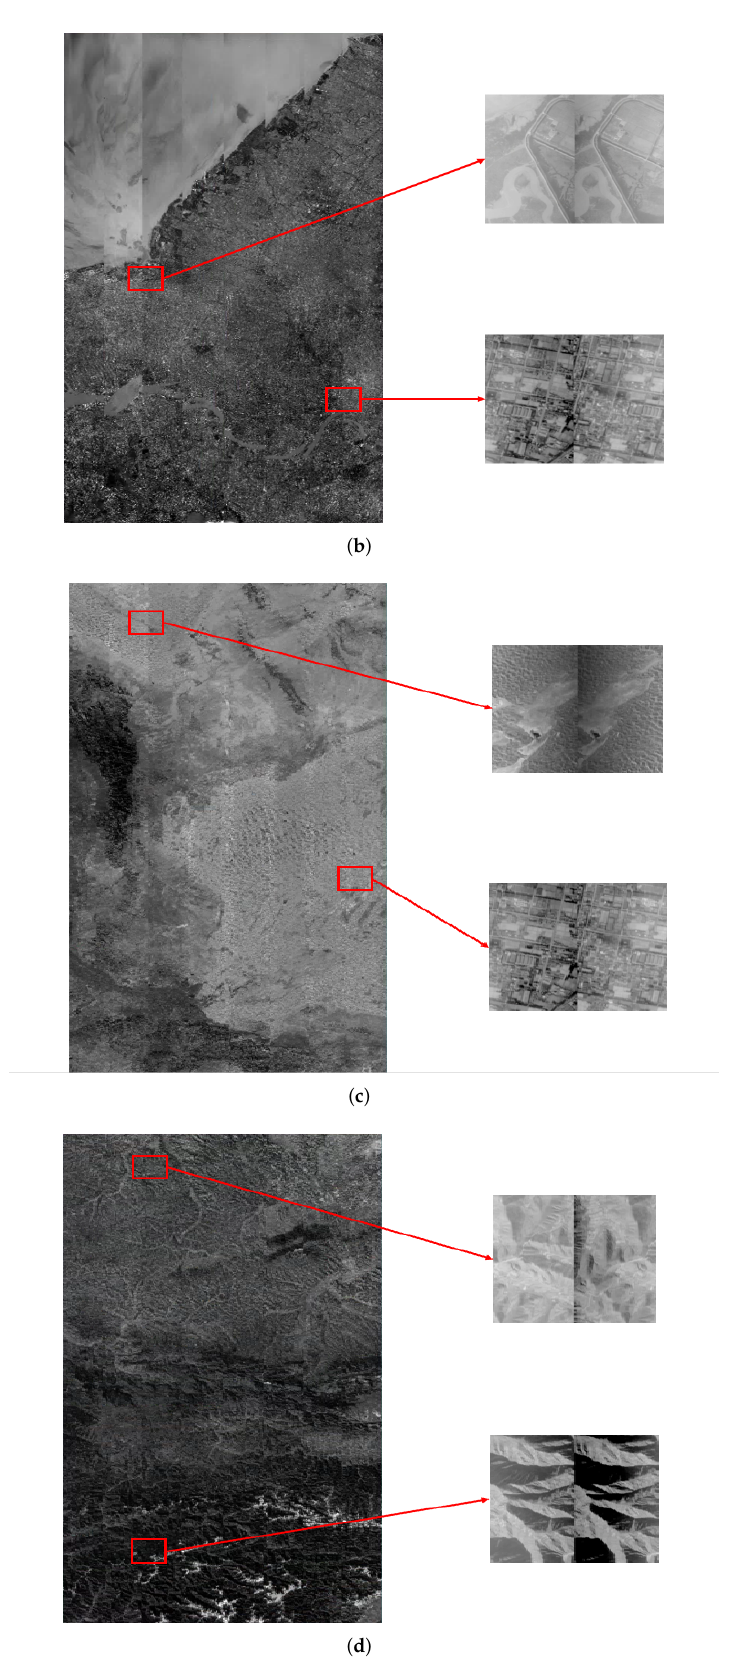
Figure 11. Illustration of detailed coverage of each dataset: ( a ) urban area in Image Data 1, ( b ) plains area in Image Data 2, ( c ) desert area in Image Data 3, ( d ) mountainous area in Image Data